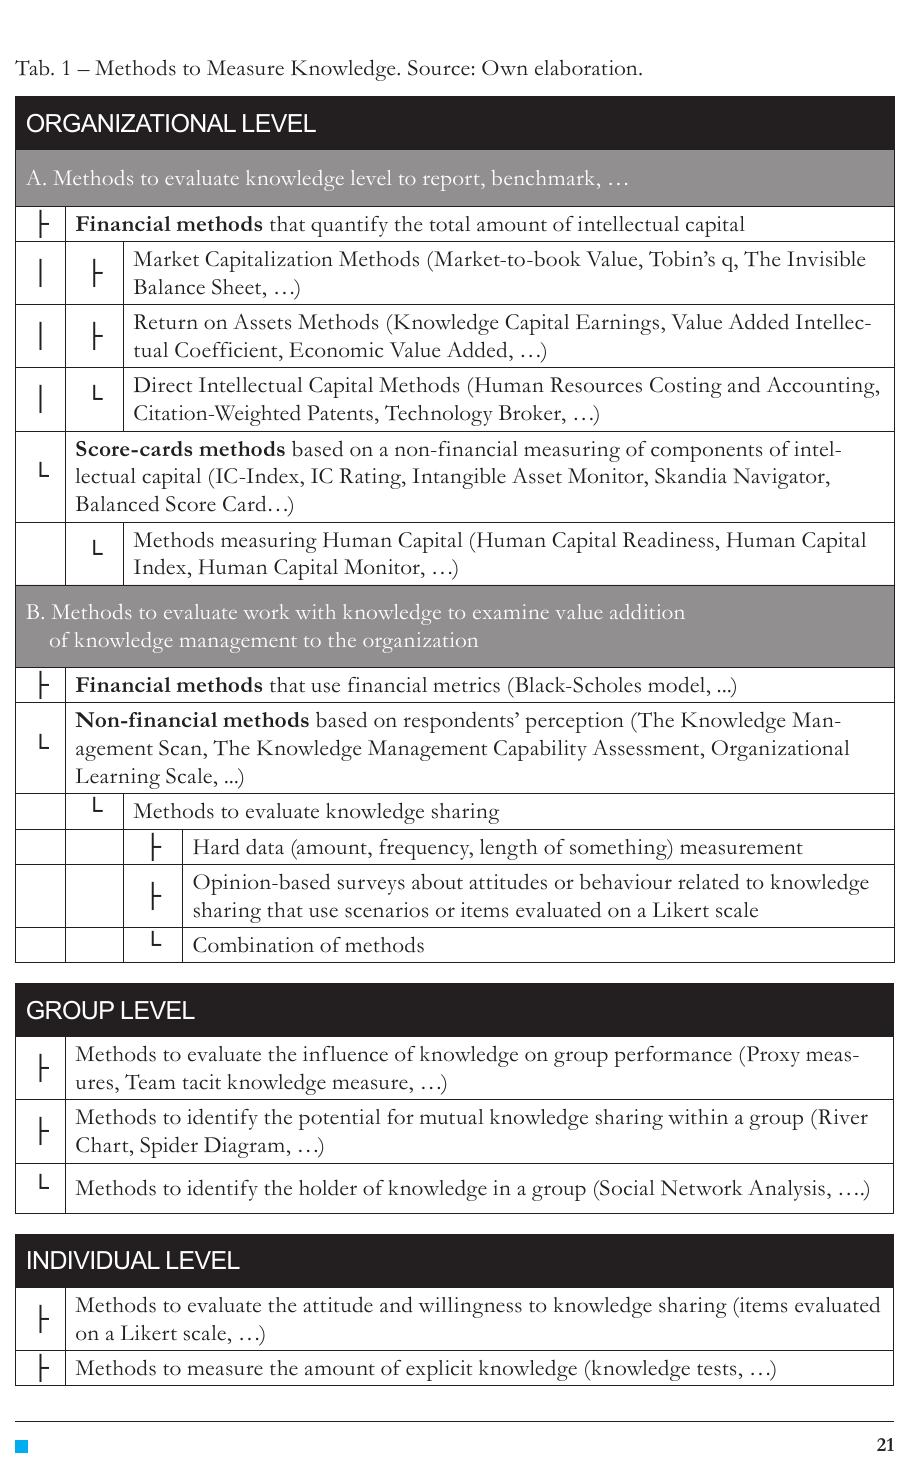
Tab. 1 – Methods to Measure Knowledge. Source: Own